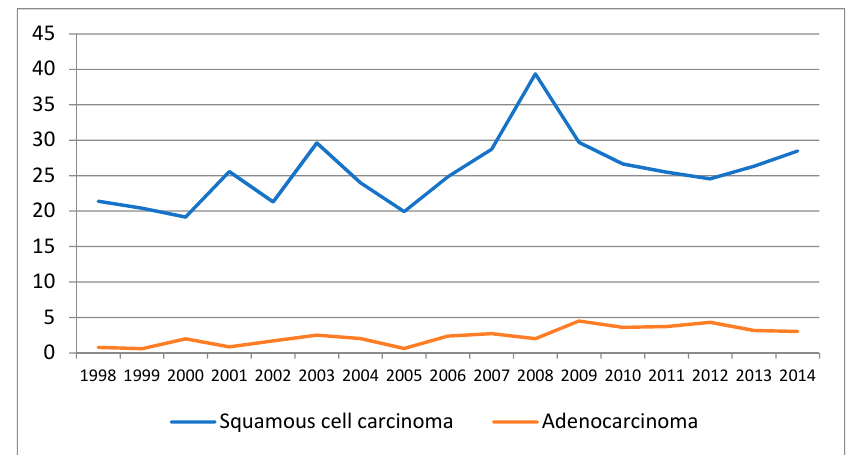
Figure 2. Evolution of standardized incidence rates (SIR) of squamous cell carcinoma and adenocarcinoma, Cluj County, 1998–2014.